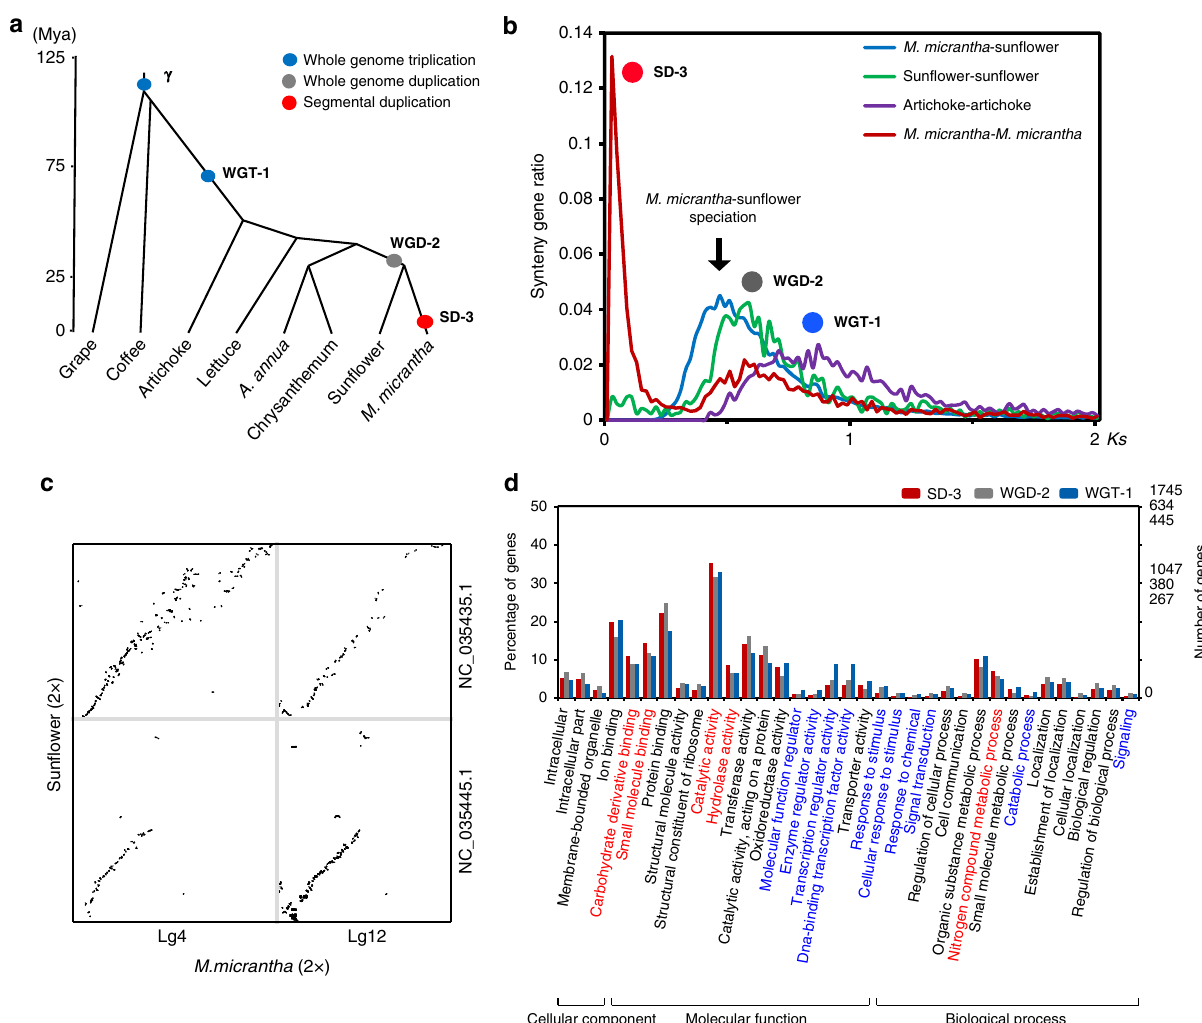
Fig. 2 Genome evolution of Mikania micrantha . a The paleohistory of the asterids, including M. micrantha , sun fl ower, lettuce, artichoke, chrysanthemum, Artemisia annua , and coffee, with grape as an outgroup. A whole-genome duplication event (WGD-2) occurring before M. micrantha- sun fl ower divergence (approximately 32 – 36 Mya), and the shared ancestral whole genome triplications WGT- γ (approximately 122 – 164 Mya) and WGT-1 (approximately 53 – 62 Mya). Circles indicate the ages of WGT-1 (blue), WGD-2 (gray) and SD-3 (red). b K s distribution of syntenic orthologues from M. micrantha , sun fl ower and artichoke. The y -axis shows the ratio of gene pairs in the syntenic block. The polyploidization (WGT-1, WGD-2, and SD-3) and speciation ( M. micrantha - sun fl ower) events are referenced on the peaks. c Dot plots of syntenic orthologues in two chromosomes between M. micrantha and sun fl ower. d The functional enrichment of WGT-1, WGD-2, and SD-3 duplicated genes in M. micrantha by Gene Ontology (GO) classi fi cation. The signi fi cantly enriched GO terms for the SD-3 and WGT-1/WGT2 duplicated genes are marked by red and blue,